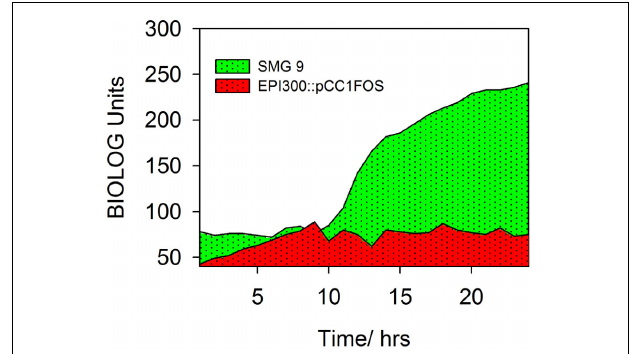
FIGURE 3 | Kinetic data measured by BIOLOG Omnilog system. Color formation within each well was measured by BIOLOG’s Omnilog machine, which produces a color coded graph. Kinetic data from two clones can be compared. EPI300::pCC1FOS is shown in red and that from SMG 9 is shown in green. The green color indicates more rapid metabolism by SMG 9 under the conditions in the well (6% NaCl + L-carnitine).